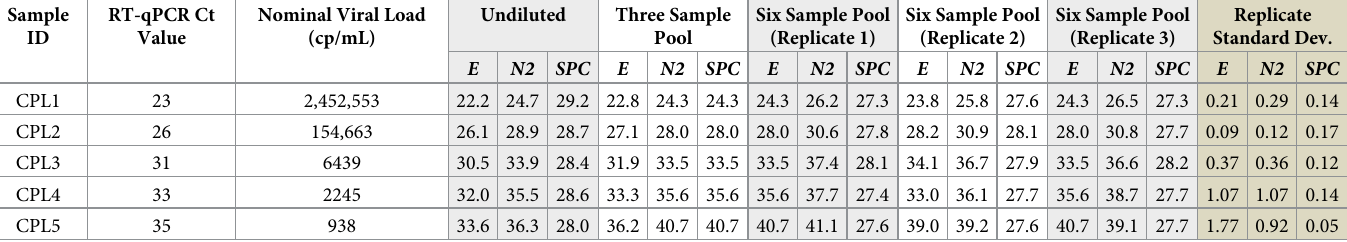
Table 1. Five clinical samples collected at the Cadham Provincial Laboratory (CPL) were selected for analysis with Ct values ranging from 23–35 as determined by the CPL in-house RT-qPCR test. Sample ID